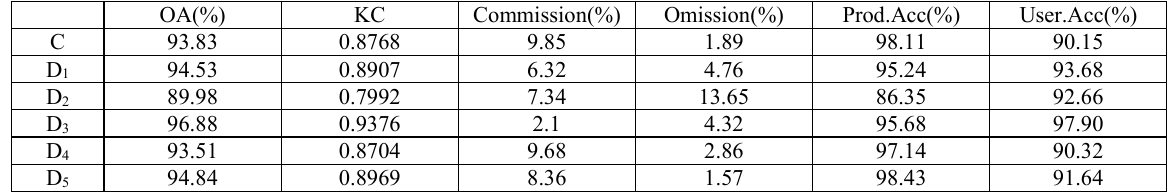
Table 1. Comparison of the results of the two Otsu